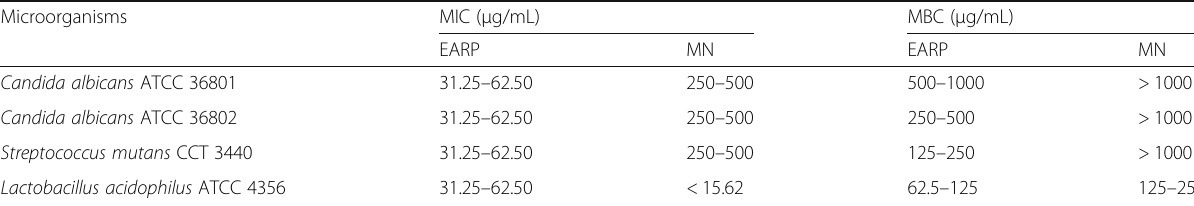
Table 2 Minimal inhibitory concentration (MIC) and minimal bactericidal concentration (MBC) of ethyl acetate extract of Brazilian red propolis and micellar nanocomposite loaded with Brazilian red propolis for Streptococcus mutans , Lactobacillus acidophilus ,